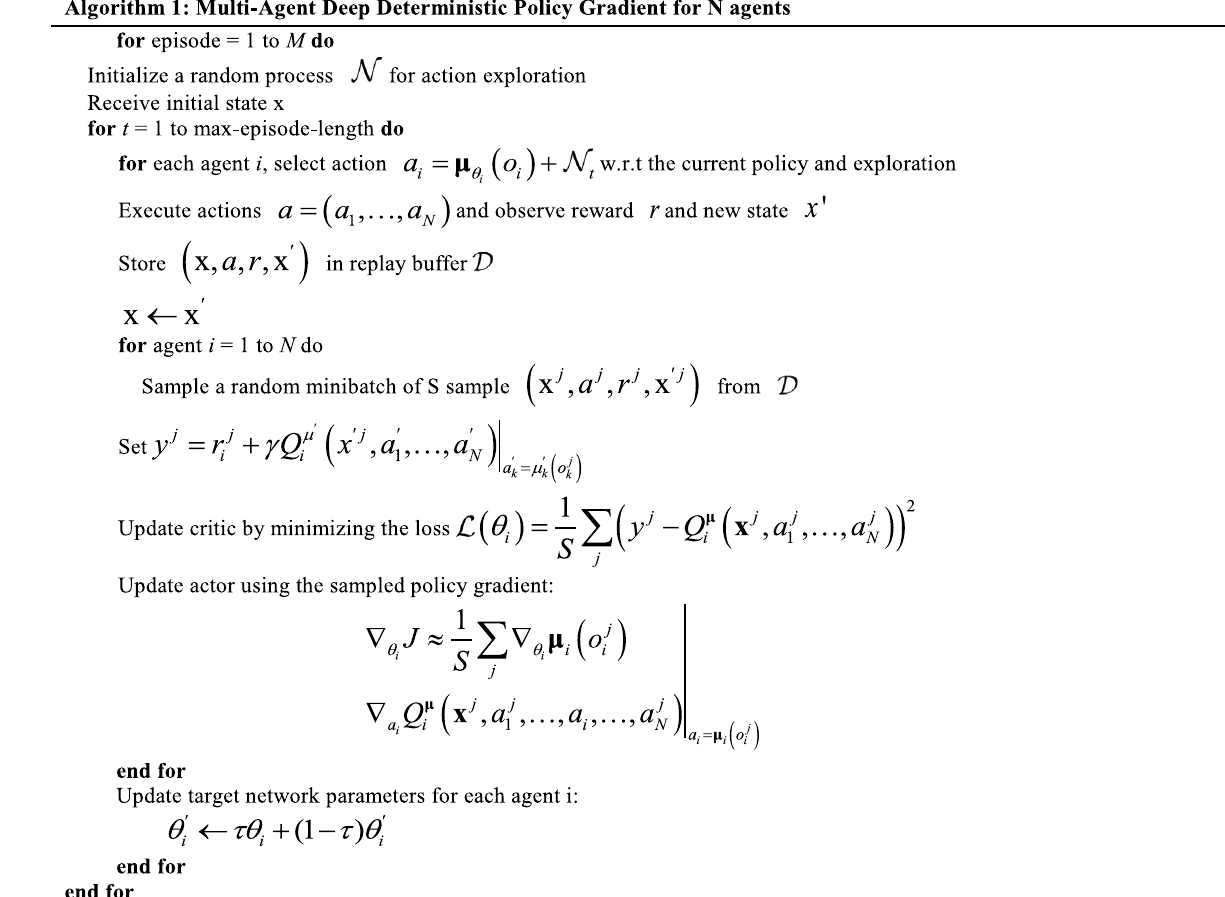
TABLE 1 | Algorithm of